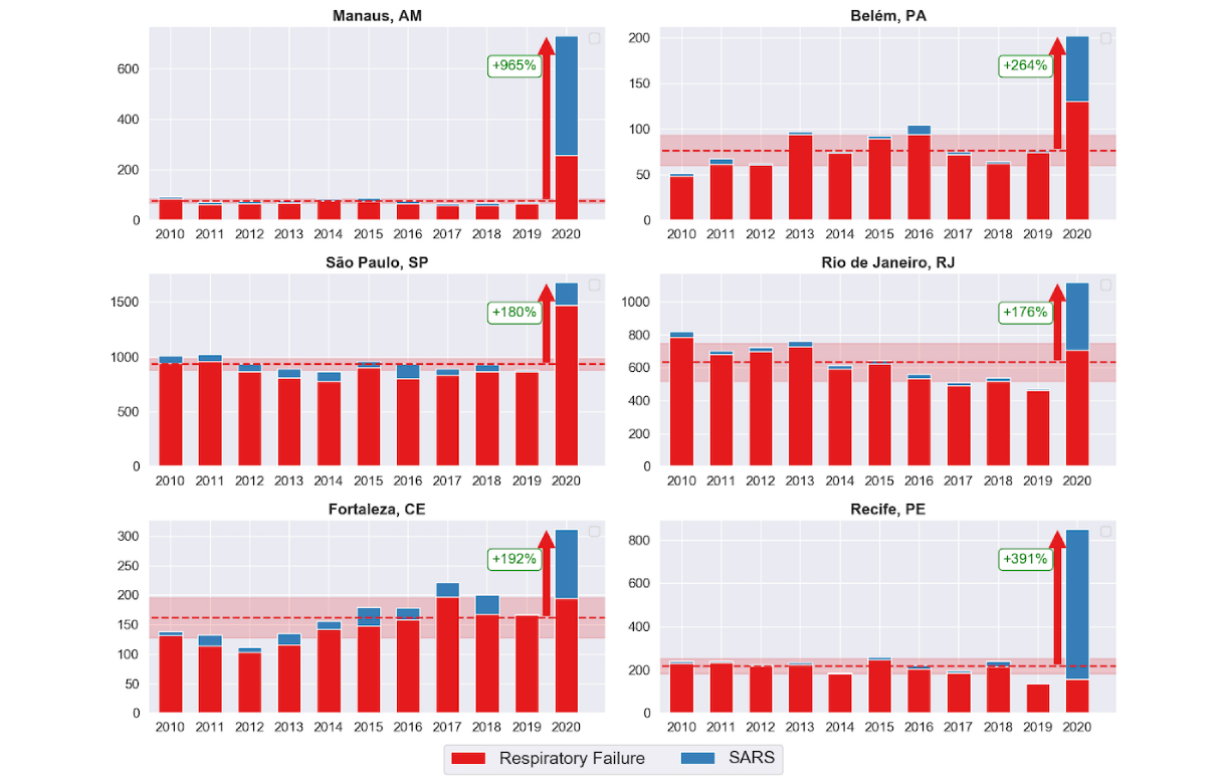
Figure 2. Increases in the number of deaths due to respiratory failure and severe acute respiratory syndrome (SARS).